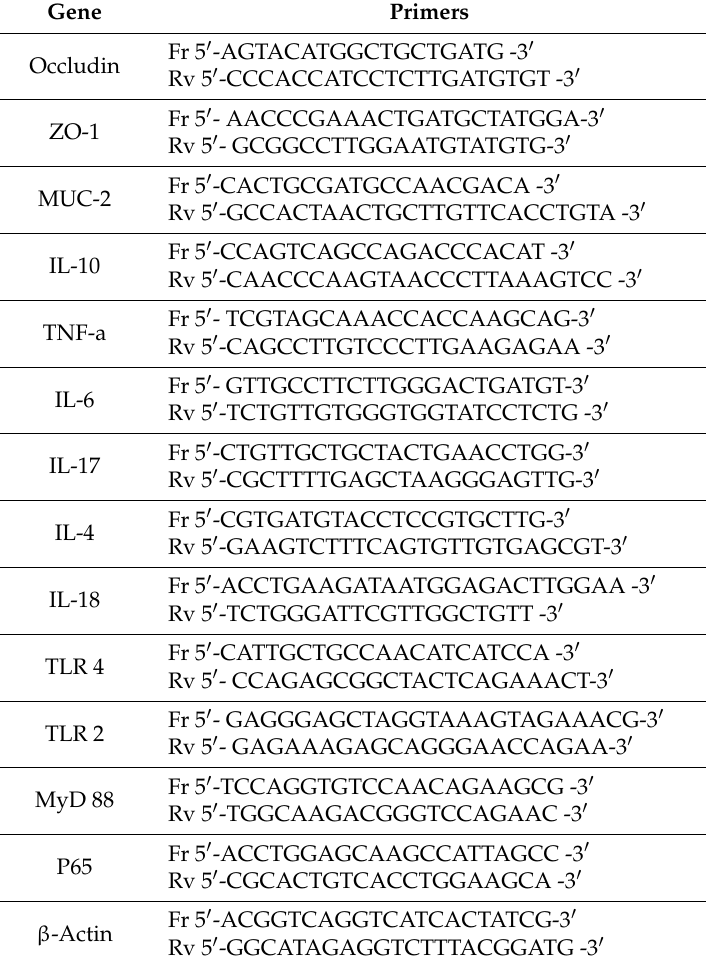
Table 5. Primer sequences used for the real-time PCR